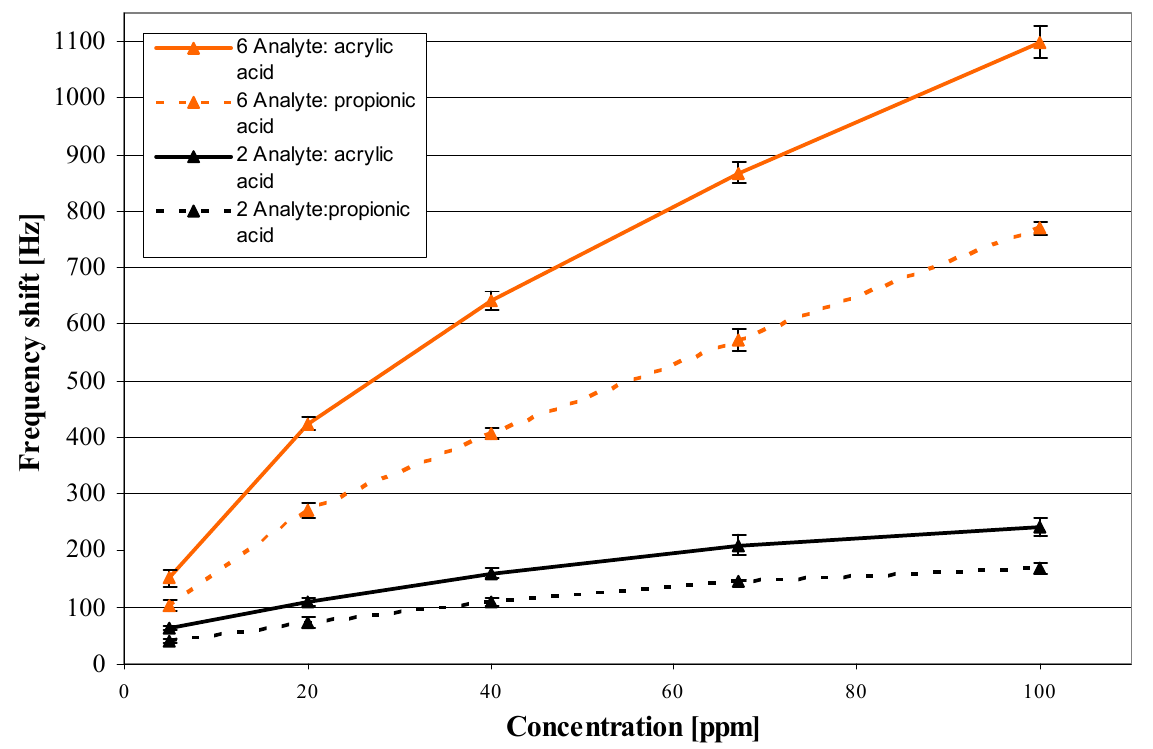
Figure 8. Characteristic responses of the analytes acrylic acid and propionic